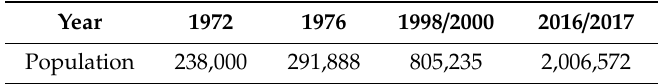
Table 2. Population data of ICT for 1972, 1976, 1998 / 2000, and 2016 /